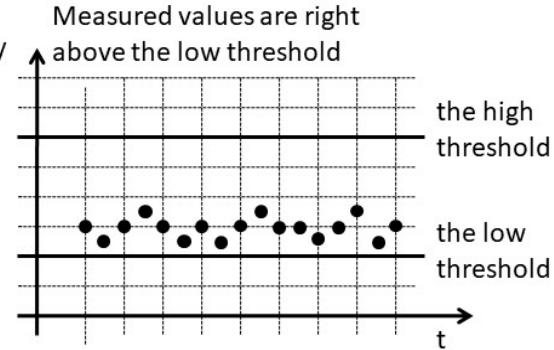
Figure 4. Limits of the threshold: the “above the low threshold” problem.